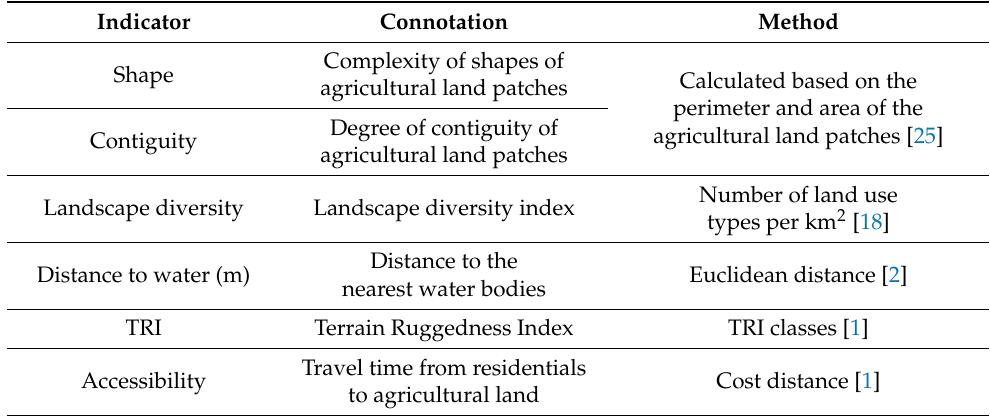
Table 2. Description of the indicators utilized in assessing agricultural CES